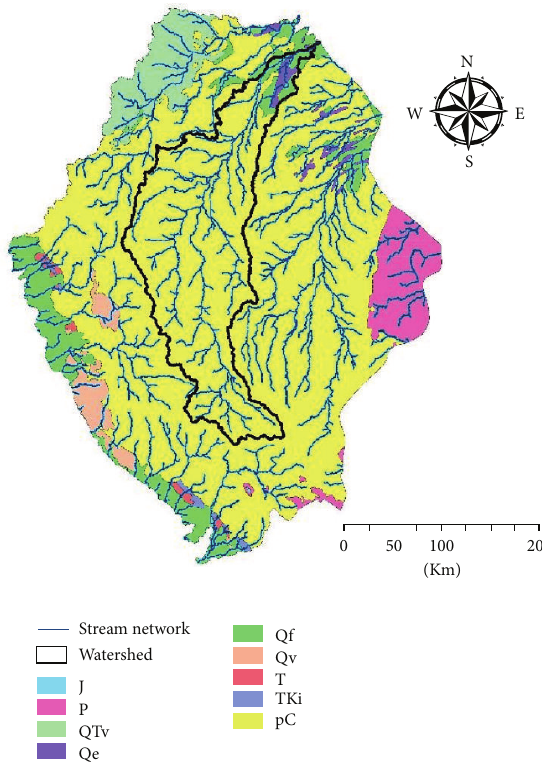
Figure 10: Cloudy areas within the watershed placed over the geology map of the southern part of KSA to locate areas suitable for potential groundwater